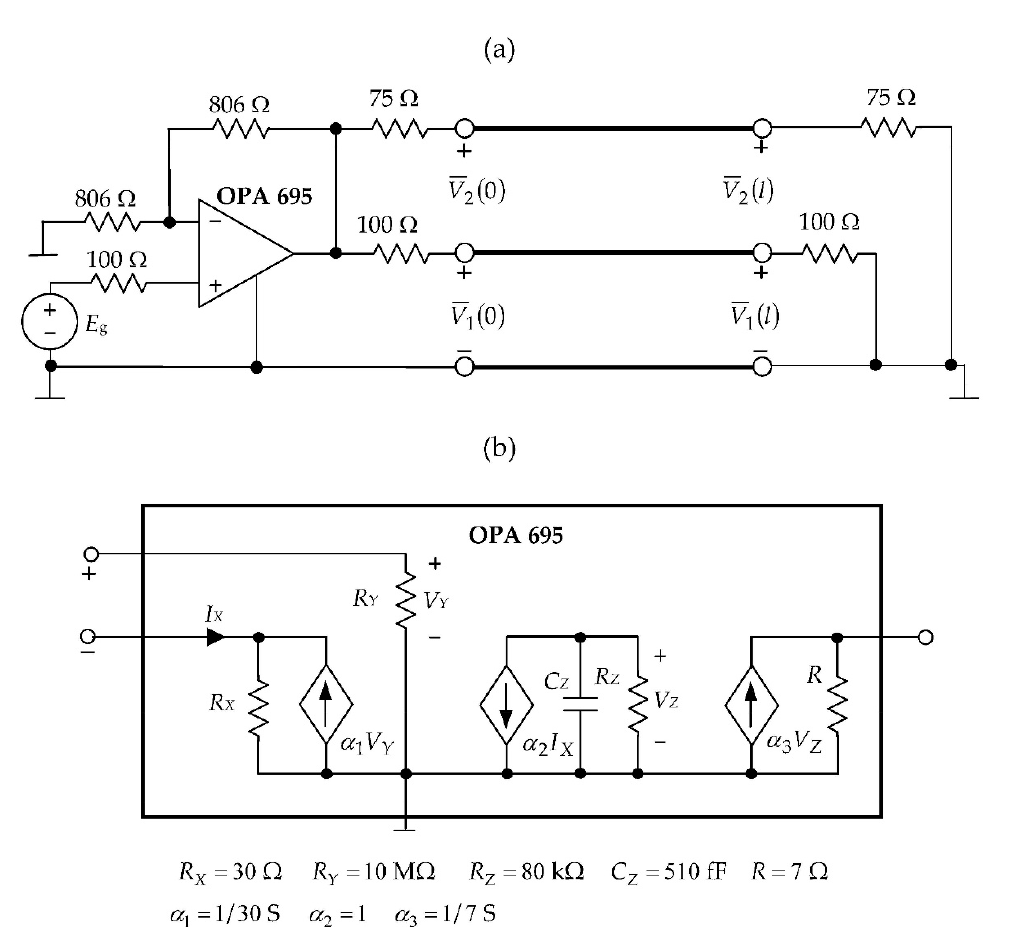
Figure 4. Electronic circuit including three-conductor transmission line ( a ) and the OPA 695 model ( b ).